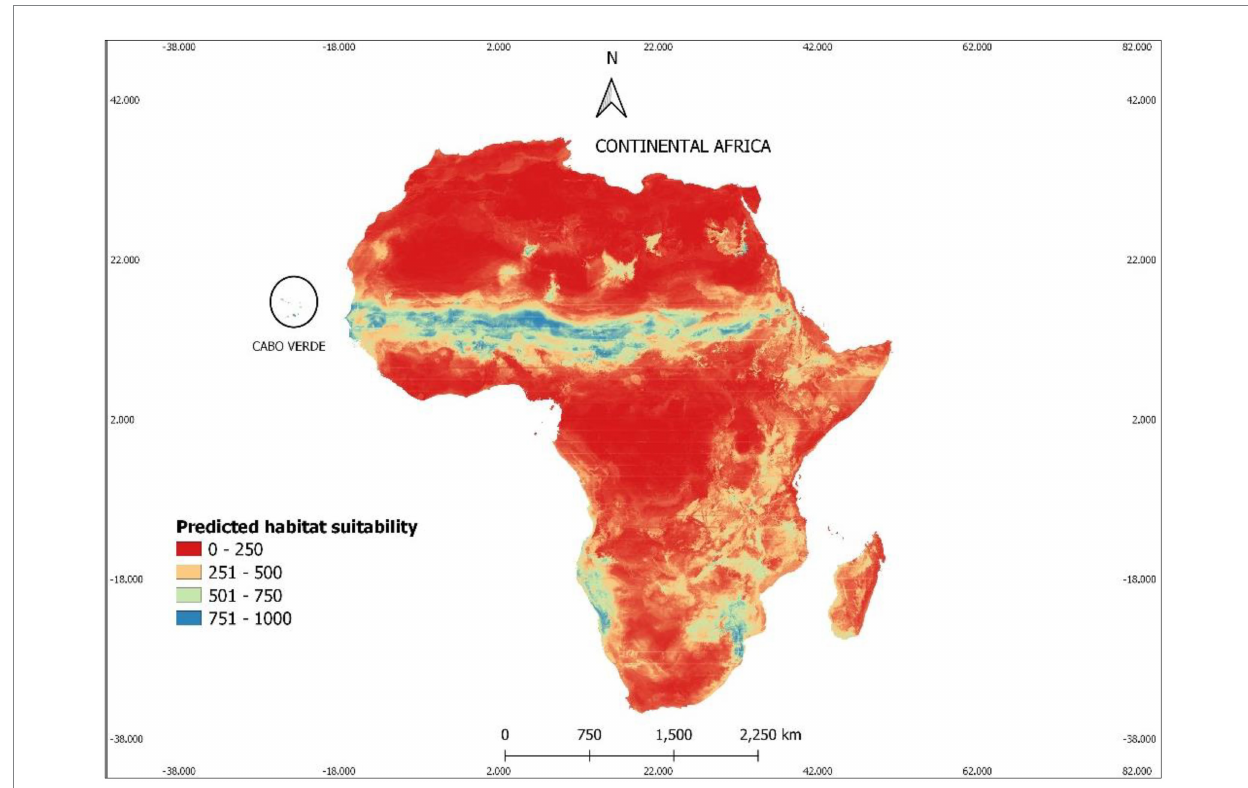
FIGURE 6 The current suitable area for Faidherbia albida in Africa, according to the results of climatic modelling. Suitable areas correspond to probabilities of occurrence above 50%. The colors indicate predicted suitable habitats ranging between red (low) and blue (high). Habitat suitability values in the 0–1,000 format, to facilitate